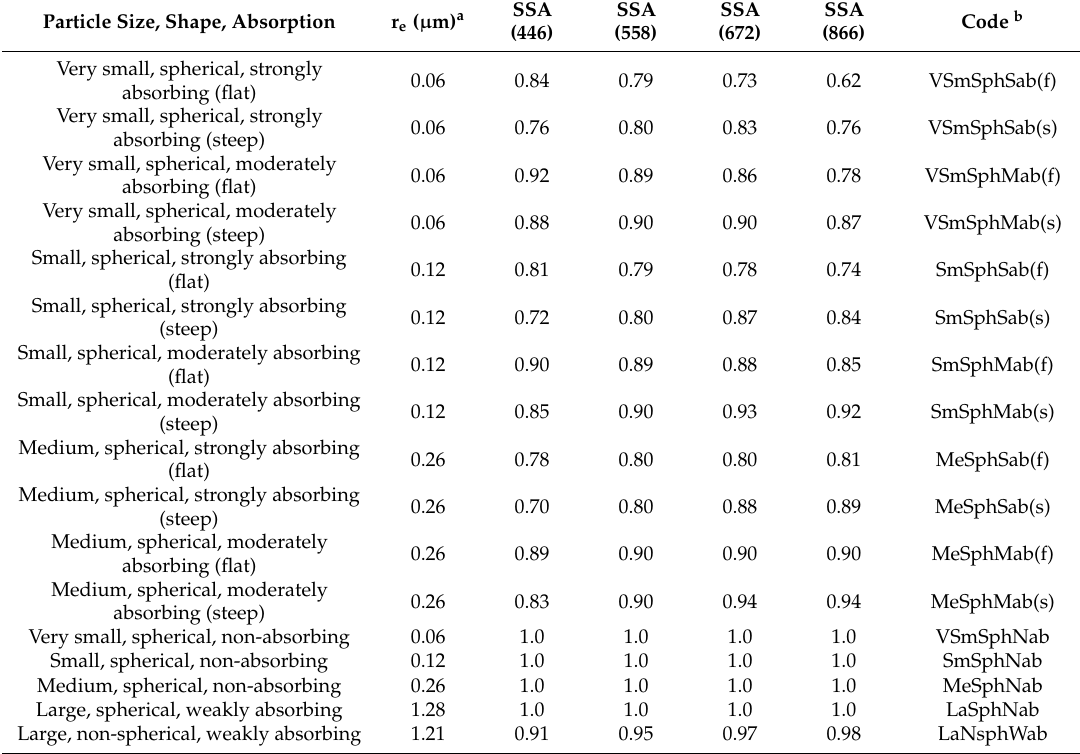
Table 2. MISR components from Research Aerosol (RA) retrieval results, using the algorithm